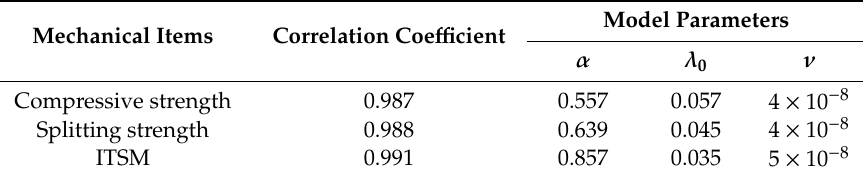
Table 1. Fitting results of damage evolution model parameters.